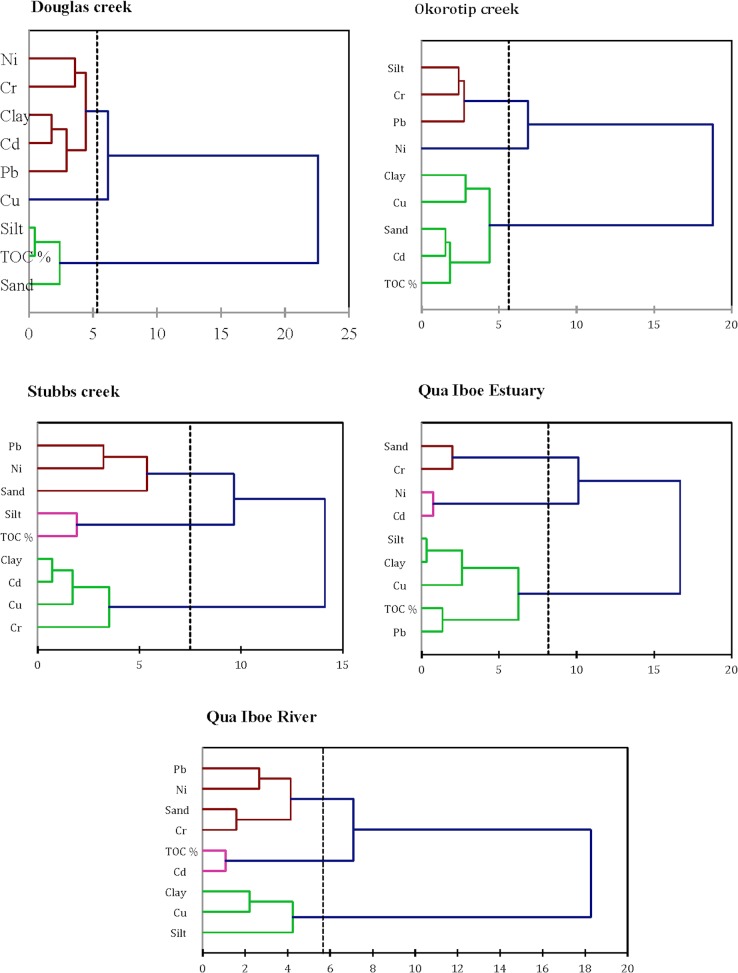
Hierarchical clustering analysis (Ward's Method) showing the relevant association among the parameters.Distance metrics are based on the Euclidean distance single linkage method (proximity matrix).